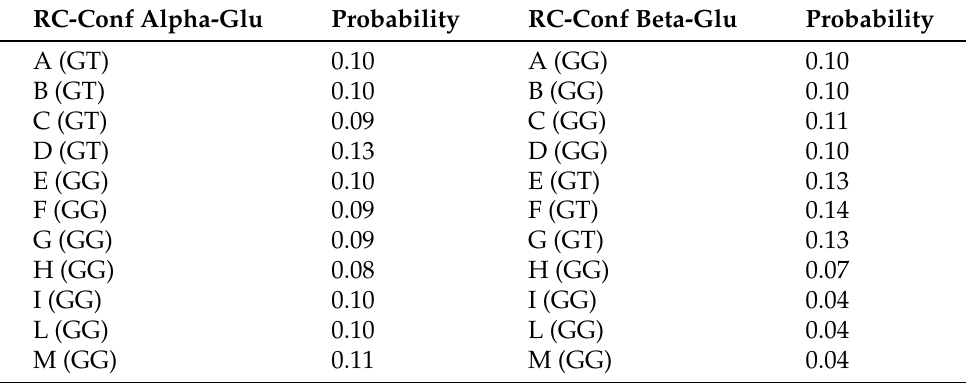
Table 1. Probability of the conformations (from A to M) corresponding to the RCs, as obtained by the MD-free for Alpha-Glu and Beta-Glu. The rotamer involved in each conformation is indicated in parentheses.